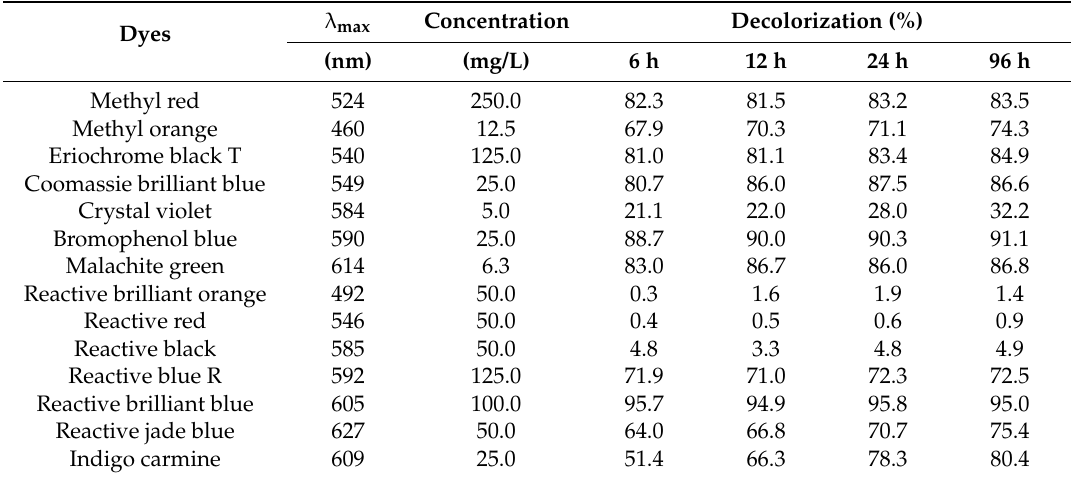
Table 4. Decolorization of different dyes after incubation with Lepista nuda laccase for different durations. λ max Dyes